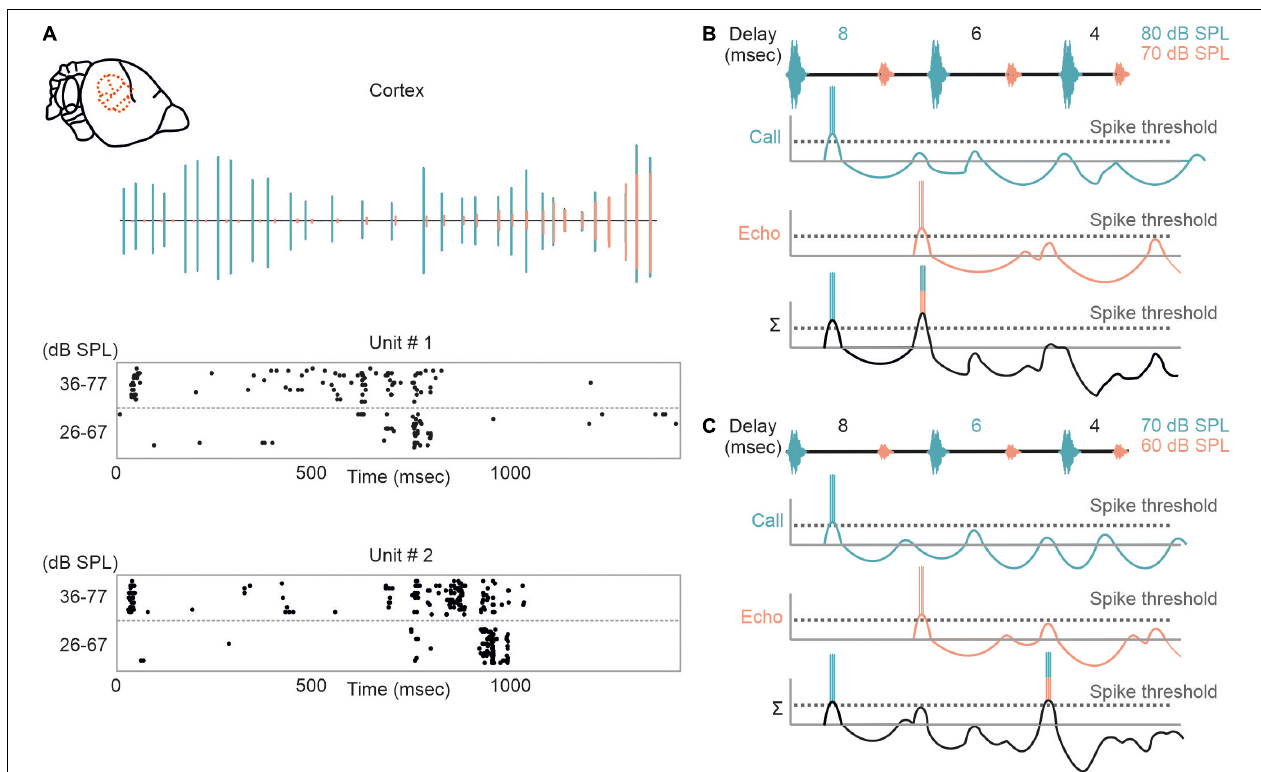
FIGURE 6 | Intensity-dependent shifts in delay tuning in the auditory cortex. (A) Neural response of two cortical units to an echolocation sequence is shown as raster plots. (Top) Oscillogram of the sequence with calls and echoes depicted in green and orange, respectively. The sequence was presented at two different intensity ranges (36–77 and 26–67 dB SPL). Note, that the units respond earlier when the bat was stimulated with the high intensity range. (B,C) Proposed model explaining the intensity-dependent shift in delay tuning. When stimulated with an intense sequence (80–70 dB SPL), the non-monotonicity of the neuron elongates the inhibitory component and thus the rebound coincides with the initial excitation evoked by the first echo. Delay tuning gets shifted toward shorter delays (6 ms) when the bat gets stimulated with a fainter sequence (70–60 dB SPL). This results from a shortening of inhibition due to the